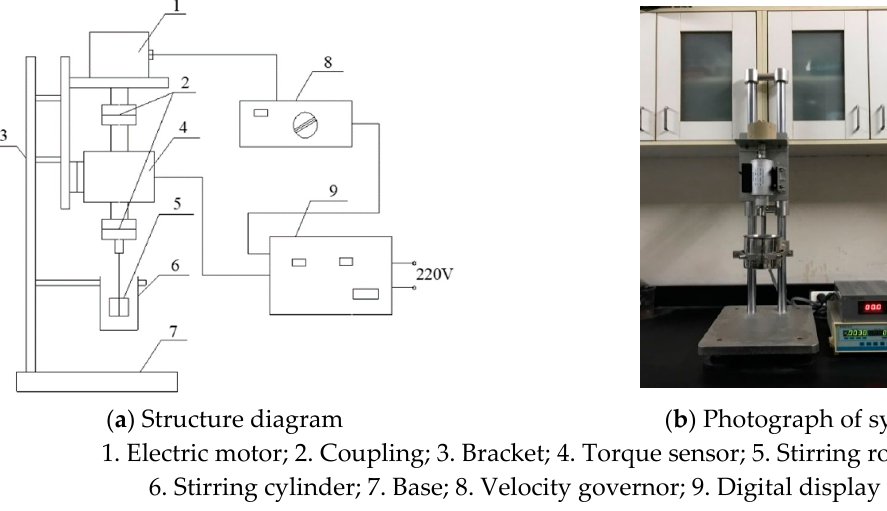
Figure 1. ( a ) Schematic and ( b ) photograph of a rheometer for high-concentration coal gangue backfill slurry (HCGS rheometer) structure.